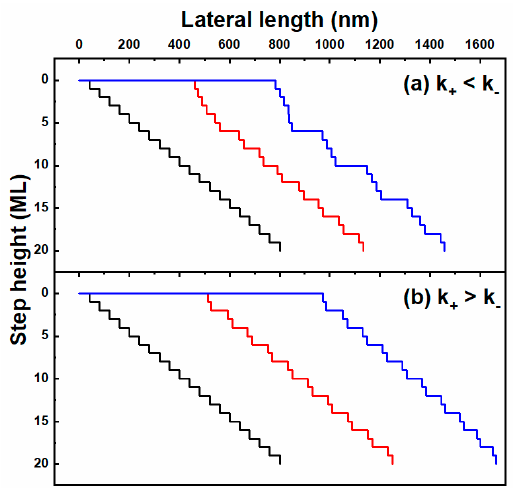
Figure 8. Surface profiles of morphological evolution on the upstream edge of stripes along the m-direction ignoring nucleation in the presence of negative ESB ( a ) and positive ESB ( b ). The different color lines show different growth stages (transition from black to red and finally blue).